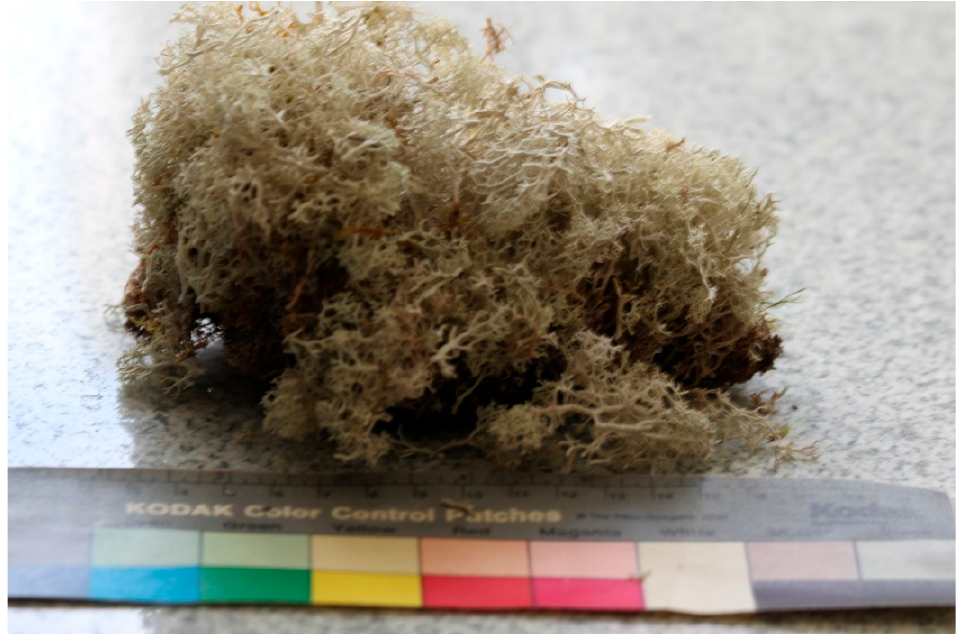
Figure 3. S ample from location No 4. Figure 3. Sample from location No